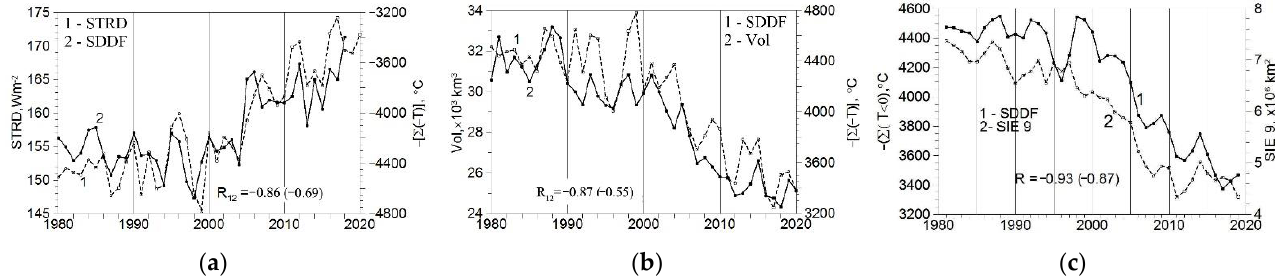
Figure 6. Variations of atmospheric parameters and sea ice in the Arctic in 1980 – 2020. ( a ) STRD in winter (1) and SDDF (2); ( b ) SDDF (1) and Vol (2) — the volume of ice in the Arctic Ocean in April; ( c ) SDDF (1) and SIE 9 from NSIDC. Series smoothed with a 3-year window. R — the correlation coefficients between series (1) and (2), in brackets — between no smoothed series.